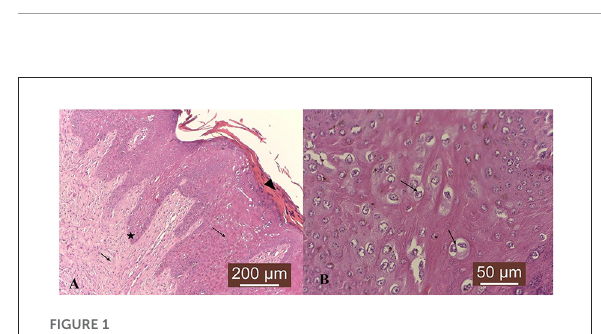
FIGURE1 Microscopic characteristics of cutaneous fibropapilloma: (A) Mild hyperkeratosis (black arrowhead), epithelial (black dotted arrow and white arrow) and dermal (black arrow) hyperplasia, accompanied by rete pegs (black star); HE, 10 X. (B) Scattered koilocytes are found in the spinosum stratum (black arrows). HE, 40